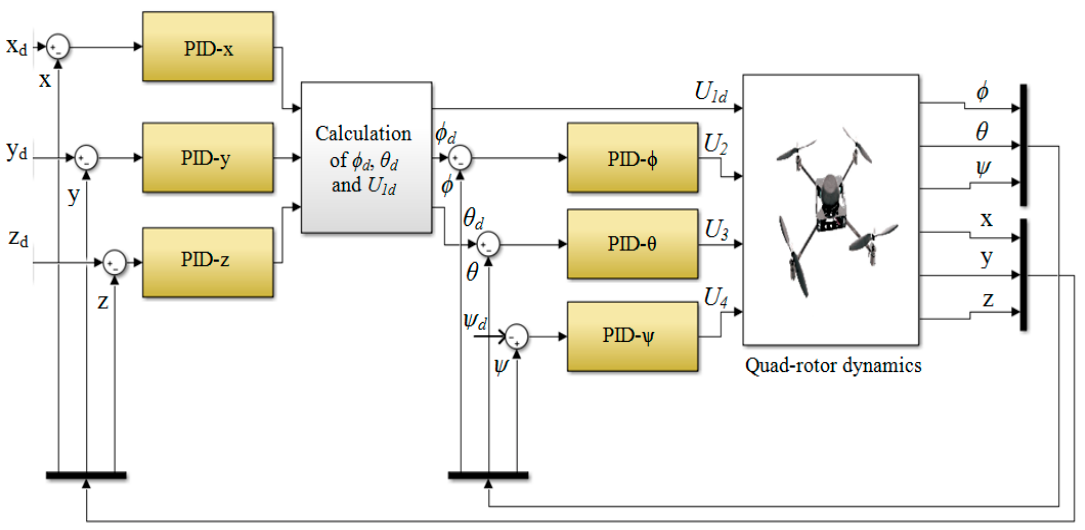
Figure 2. Complete control scheme for quadrotor.